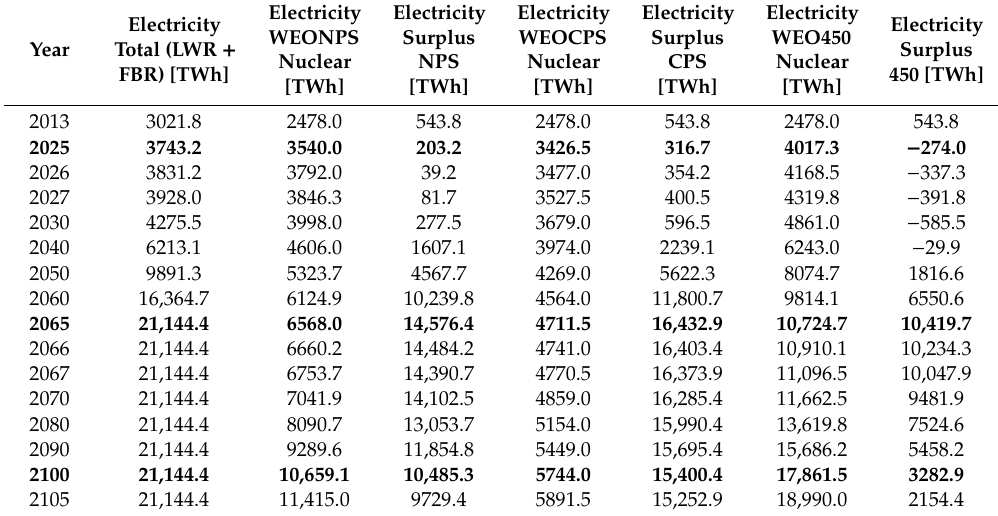
Table 5. Electricity surplus for scenario S1, sub scenario